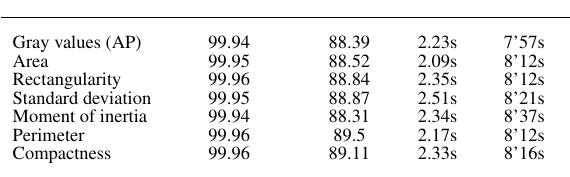
FPs with compactness filtering (30